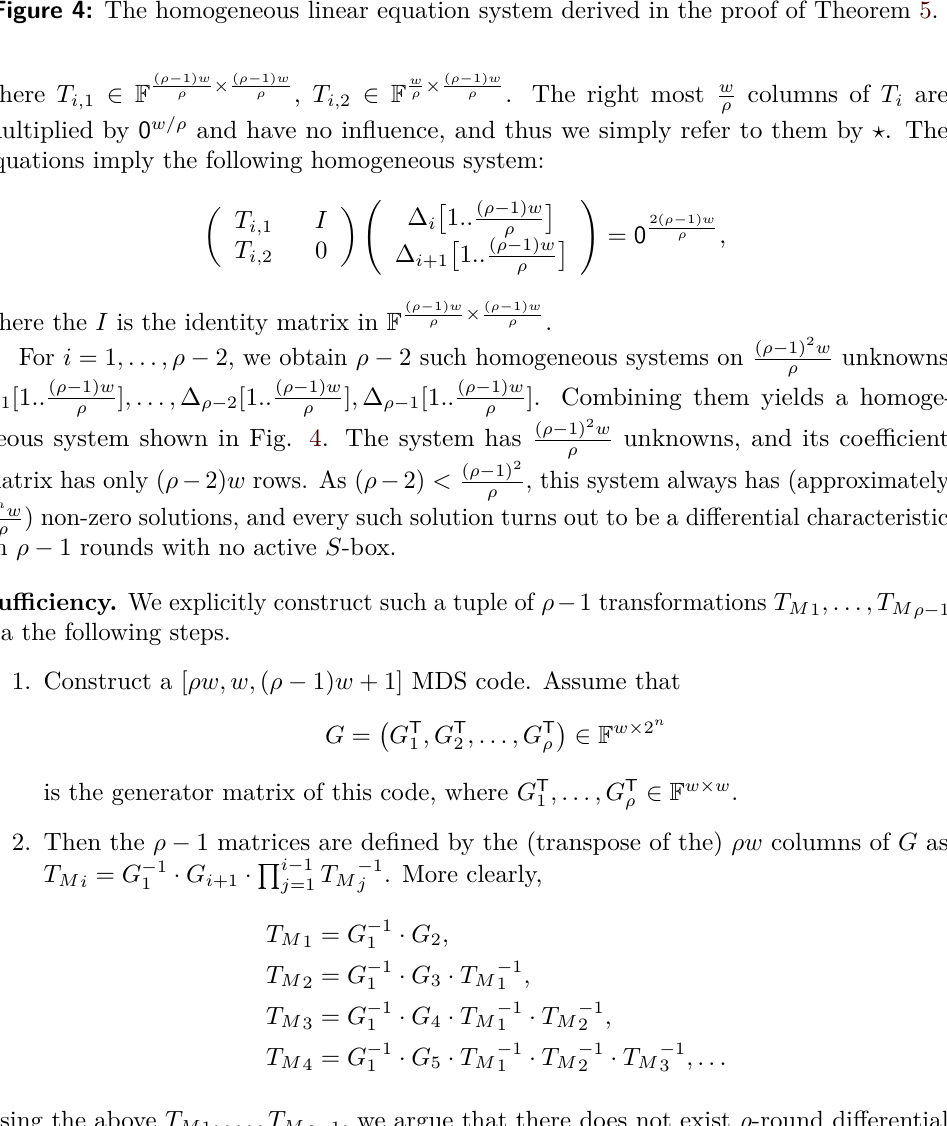
Figure 4: The homogeneous linear equation system derived in the proof of Theorem 5.